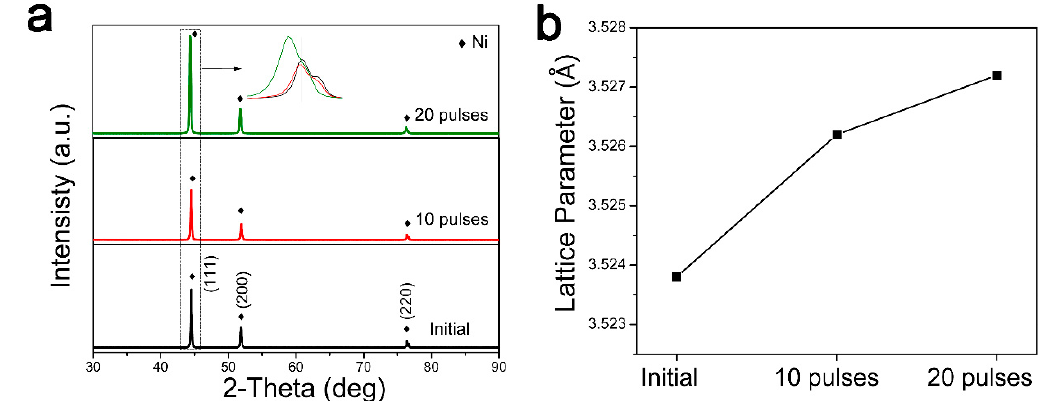
Figure 1. ( a ) XRD patterns and ( b ) lattice parameters of initial pure Ni, 10-pulse and 20-pulse HCPEB-irradiated Cr-Ni samples.